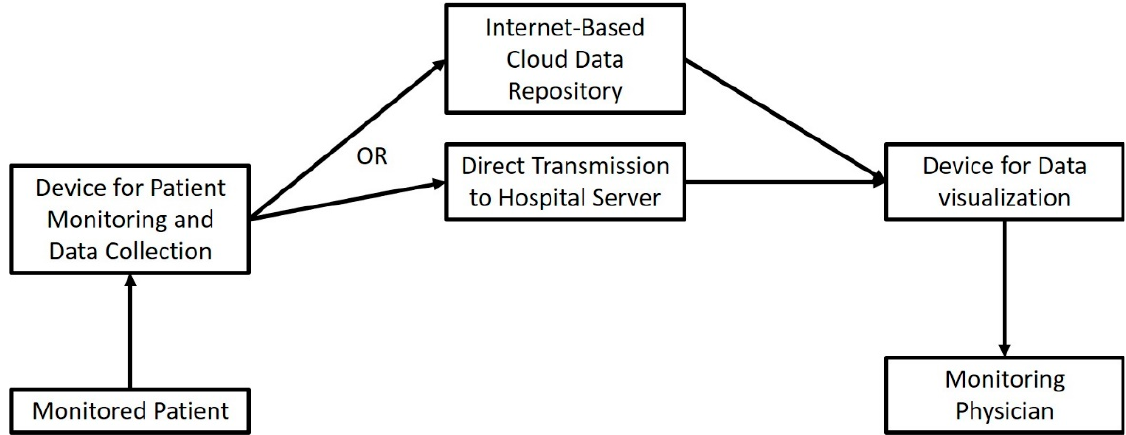
Figure 3. Connected IoST entities and workflow of an IoST-based Telemonitoring System .